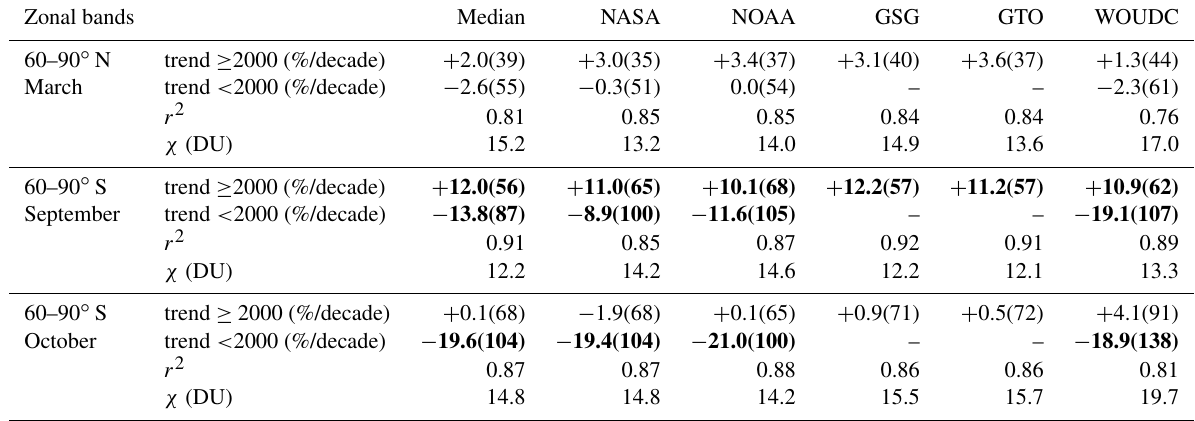
Table 5. Polar total ozone trends in March (NH), September (SH), and October (SH) before and after 2000. Uncertainties are provided for 2 σ , and trends in bold indicate statistical significance. r 2 is the square Pearson correlation and χ the residual (see caption of Table 3). The results were obtained from the full